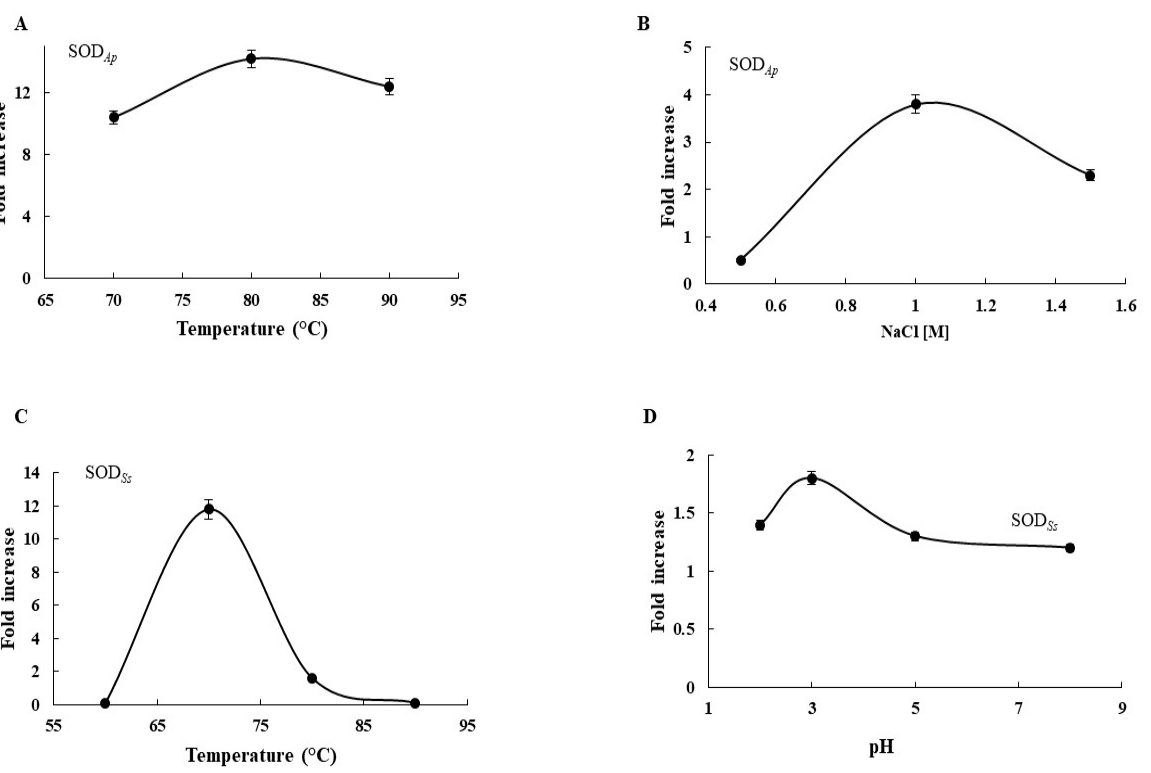
Figure 3. Biochemical analysis of transgenic extracts. Effects of ( A ) temperature and ( B ) NaCl on SOD Ap activity. Effects of ( C ) temperature and ( D ) pH on SOD Ss activity. Fold increase was calculated as ratio between SOD activity in crude protein extracts from wild-type plants and SOD activity in crude protein extracts from transgenic plants, using the NBT assay. All experiments were performed in triplicate on three different protein preparations. Data were expressed as means ± standard deviation. Standard deviation values lower than 5% were not shown.